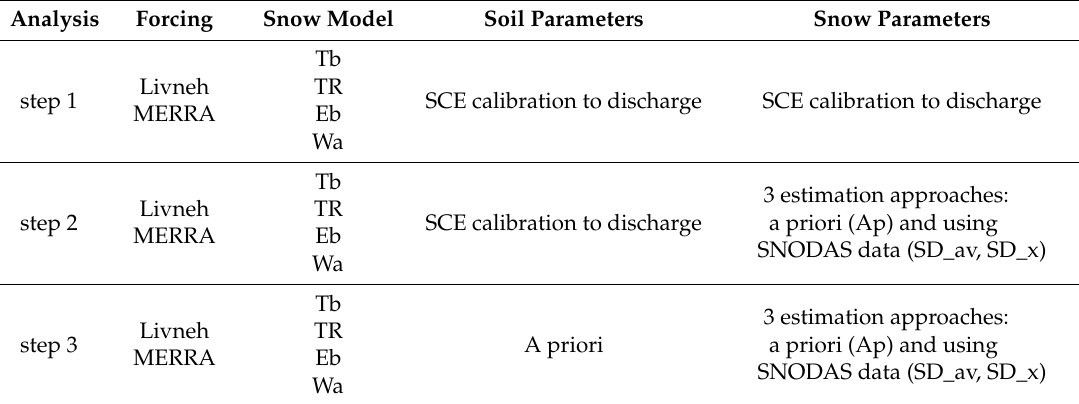
Table 2. Summary of the options considered in the